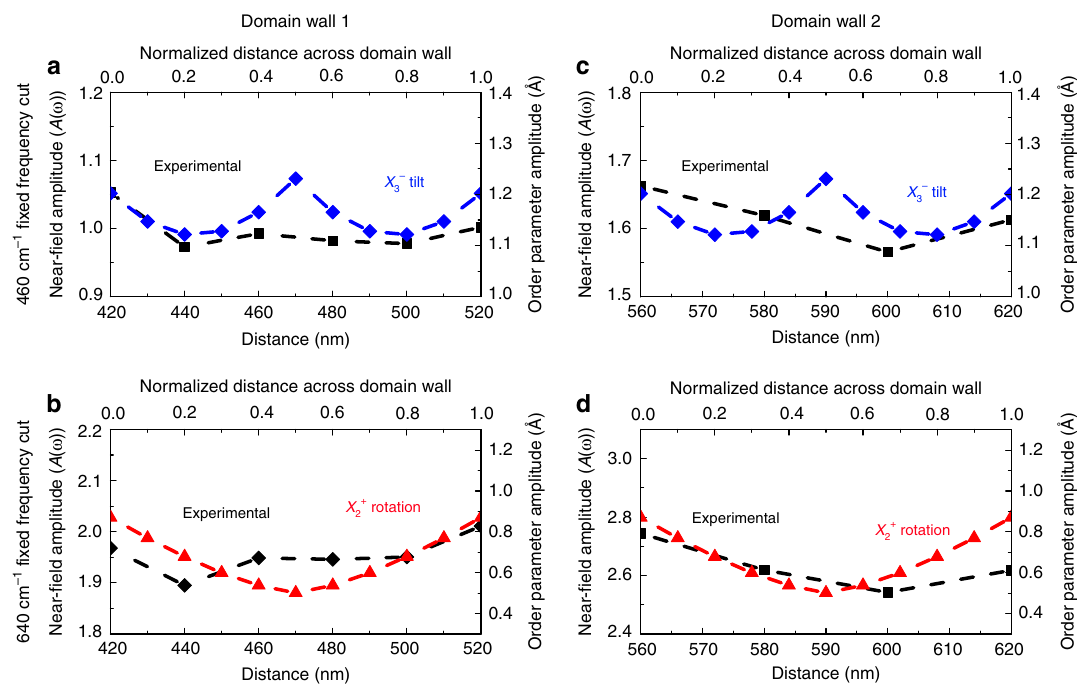
(tilt, blue diamonds) and X þ (rotation, red triangles) 3 2